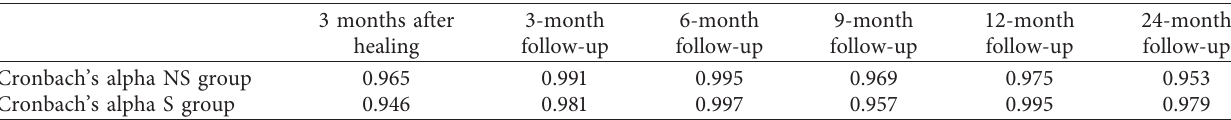
Figure 4: The nylon cap of ball attachment picked up in the fitting surface of the denture. Table 2: The interobserver consistency using Cronbach’s alpha statistics. NS: nonsubmerged and S: submerged.